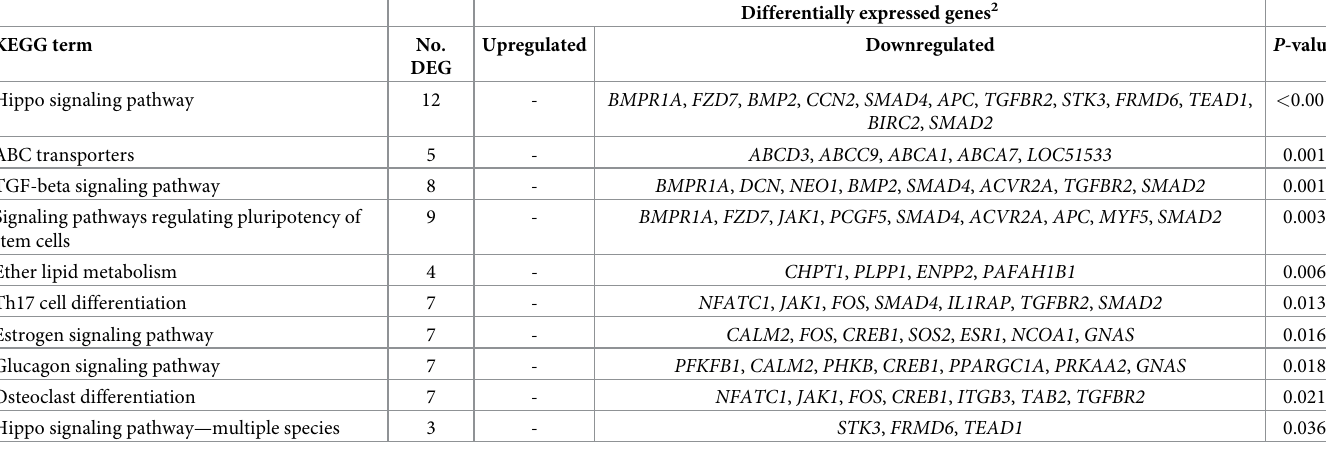
Table 1. Significantly enriched Kyoto Encyclopedia of Genes and Genomes (KEGG) pathways in the Longissimus dorsi muscle of early-weaned Bos indicus -influ- enced calves for the effect of maternal supplementation of protein and energy 1 .